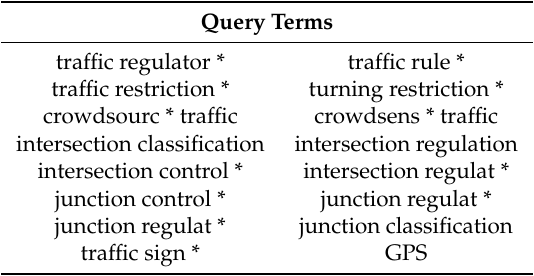
Table 3. Query terms that were used for searching the Web of Science and Scopus for the two SLC concerning concepts.